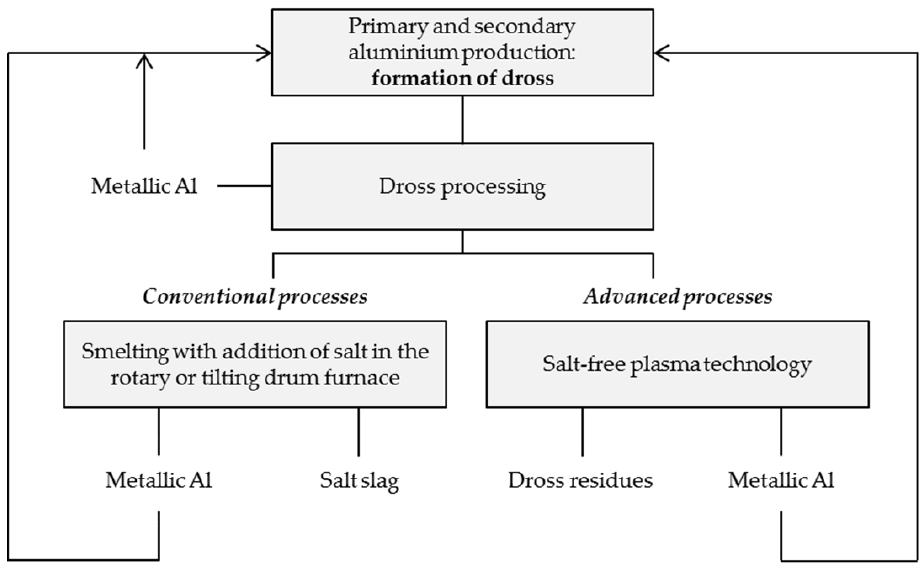
Figure 1. Flow-sheet of the dross processing methods (according to descriptions by Prillhofer et al. [16] and Meshram and Singh [17]).